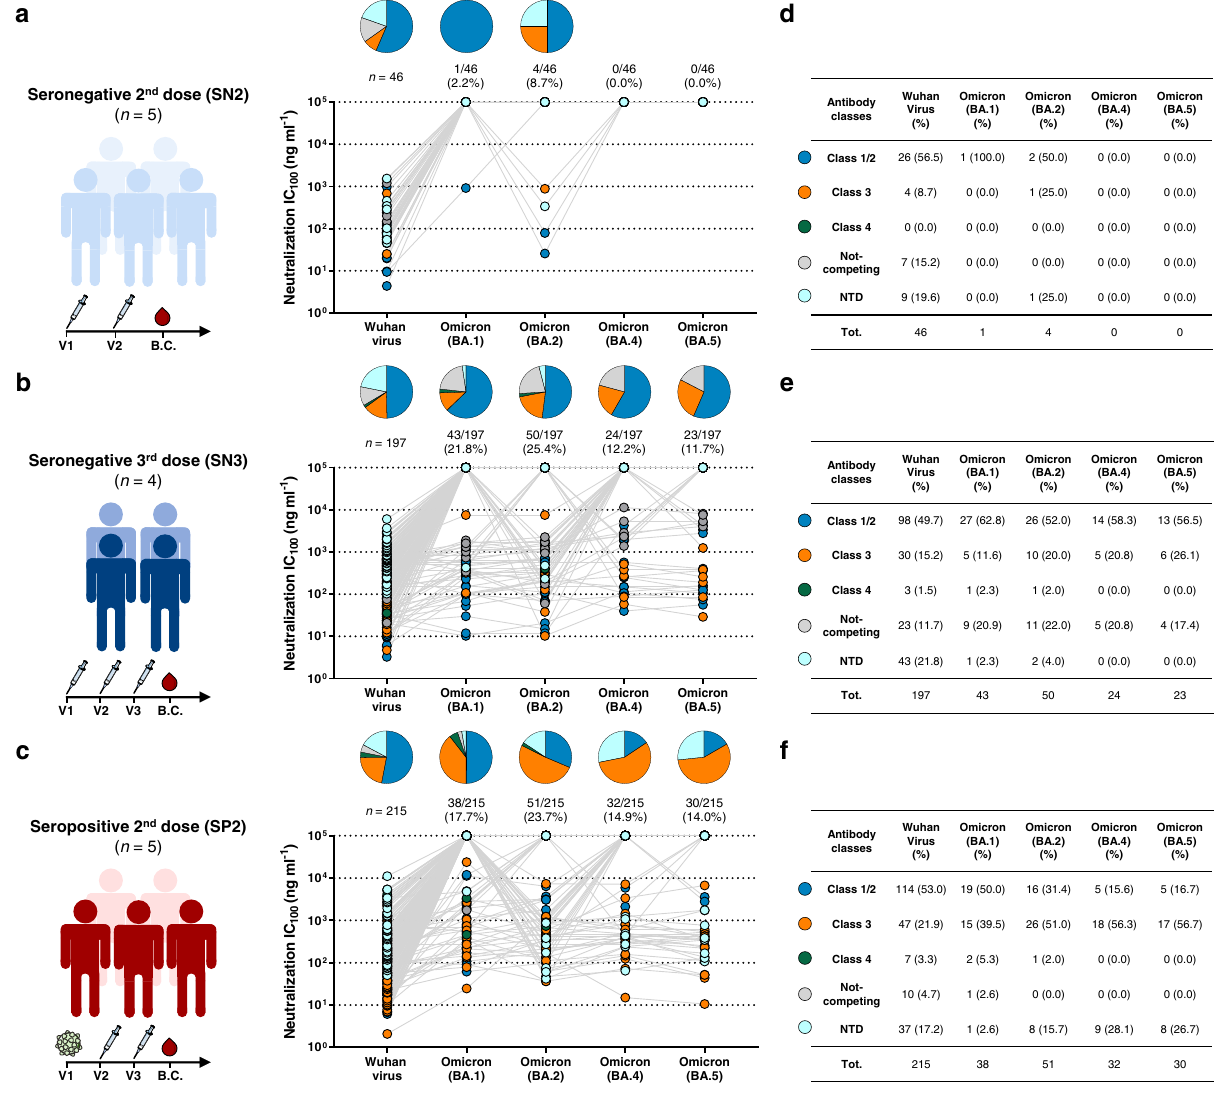
SN2 ( a ), SN3 ( b ) and SP2 ( c ) cohorts. The number and percentage of nAbs are denoted on each graph. Tables summarize number and percentage of Class 1/2, Class 3, Class 4, not-competing and NTD-targeting nAbs for each tested variant in the SN2 ( d ), SN3 ( e ) and SP2 ( f ) cohorts. Source data are provided as a Source Data fi